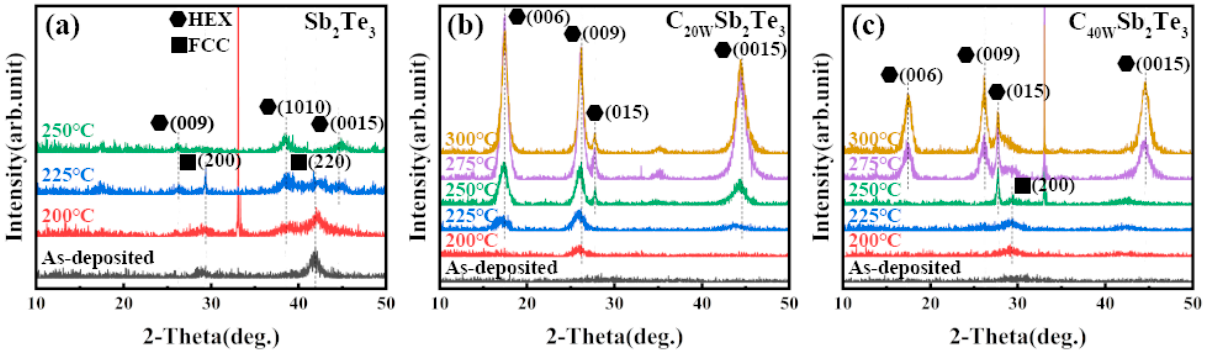
Figure 4. An XRD diagram of Sb 2 Te 3 and C-Sb 2 Te 3 in the experiment. ( a ) Sb 2 Te 3 ; ( b ) C 20W Sb 2 Te 3 ; and ( c ) C 40W Sb 2 Te 3 were annealed for 5 min at different temperatures in a N 2 atmosphere.